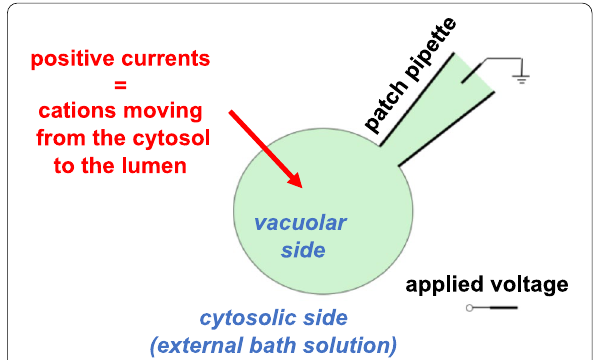
Fig. 2 Cartoon of the patch-clamp technique applied on plant vacuoles. The patch clamp technique is applied in the whole-vacuole (cytosolic side-out) configuration. Positive currents correspond to the movement of cations from the cytosolic to the luminal side of the vacuole (or to the opposite movement of